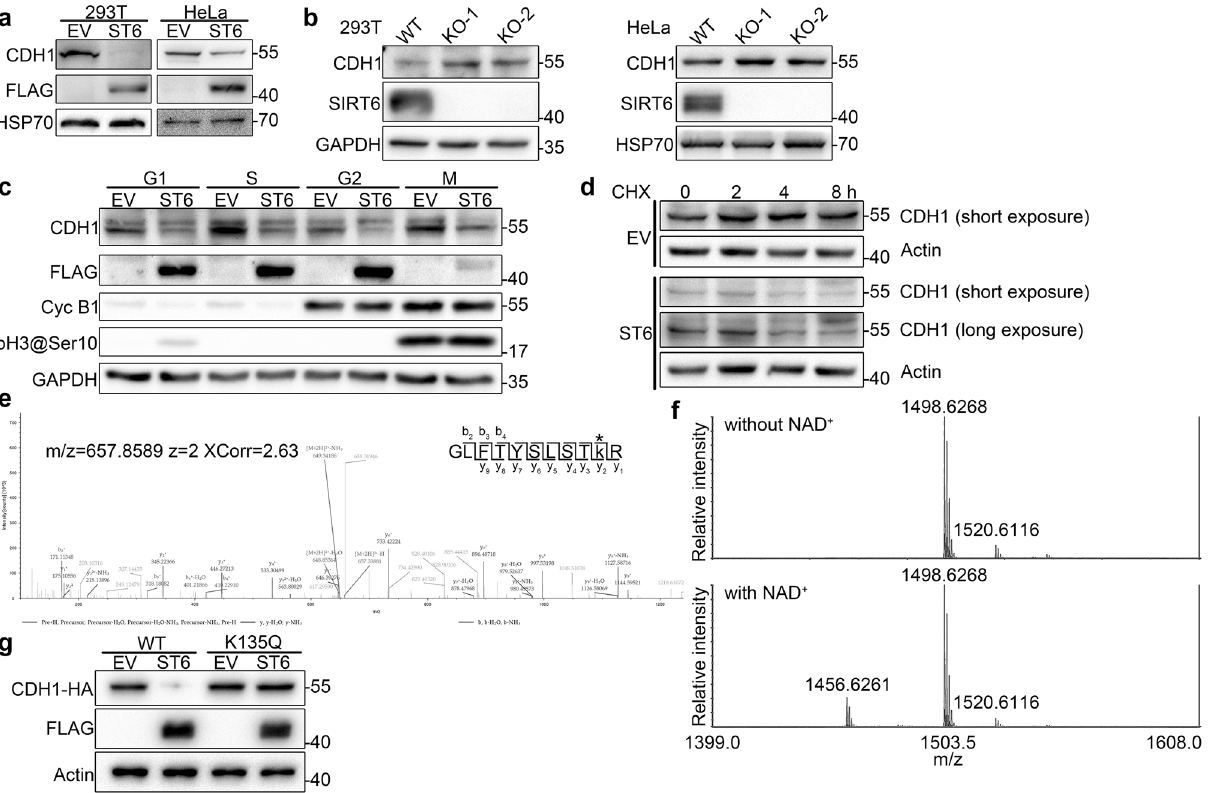
Figure 5. SIRT6 deacetylates CDH1, a co-activator of APC/C, and promotes its degradation. ( a ) Control and SIRT6-FLAG overexpressing 293 T and HeLa cells were subjected to western blotting with the indicated antibodies. HSP70 was used as a loading control. ( b ) Level of CDH1 protein was detected by western blotting in wild-type and SIRT6 knockout 293 T and HeLa cells. GAPDH and HSP70 were used as loading controls. ( c ) Control (EV) and SIRT6-overexpressing (ST6) HeLa cells were synchronized to G1, S, G2 and M phases, respectively. Levels of CDH1, FLAG, cyclin B1 and phosphorylation of histone H3 at Ser10 (pH3@Ser10) were detected with corresponding antibodies. GAPDH was used as loading control. ( d ) Control (EV) and SIRT6- overexpressing (ST6) cells were treated with 5 μg/mL cycloheximide (CHX) for 0, 2, 4, and 8 h. Levels of CDH1 were detected by western blotting. Actin was used as loading control. ( e ) Tandem mass spectrometry spectrum of the acetylated peptide for identification of Lys135 modifications in CDH1. An asterisk in the peptide sequence indicates the modified lysine residue. The image was generated with Xcalibur 3.0 (Thermo Fisher Scientific Inc.). ( f ) Synthesized peptide around CDH1 K135 with acetylation was incubated with SIRT6 without/ with NAD + . Samples were analyzed with MALDI-TOF/TOF with m/z range 1400–1600 (z = 1). ( g ) 293 T stably expressing wild-type or K135Q CDH1-HA were transfected with empty vehicle (EV) or SIRT6-FLAG expressing vector (ST6), respectively. CDH1-HA levels were detected using anti-HA antibody. Expression of SIRT6-FLAG was detected using an anti-FLAG antibody. Actin was used as a loading